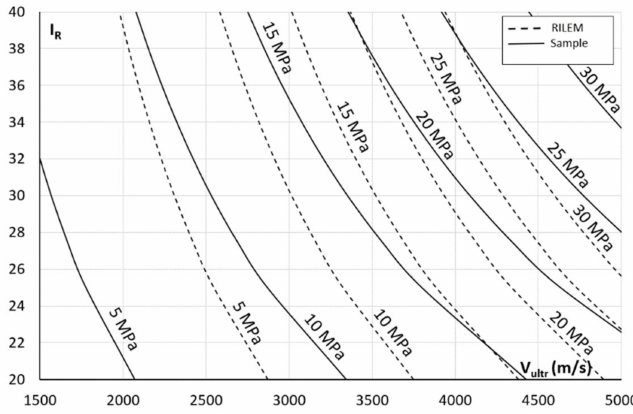
Figure 5. SonReb method: comparison between the RILEM and the author’s formulations.